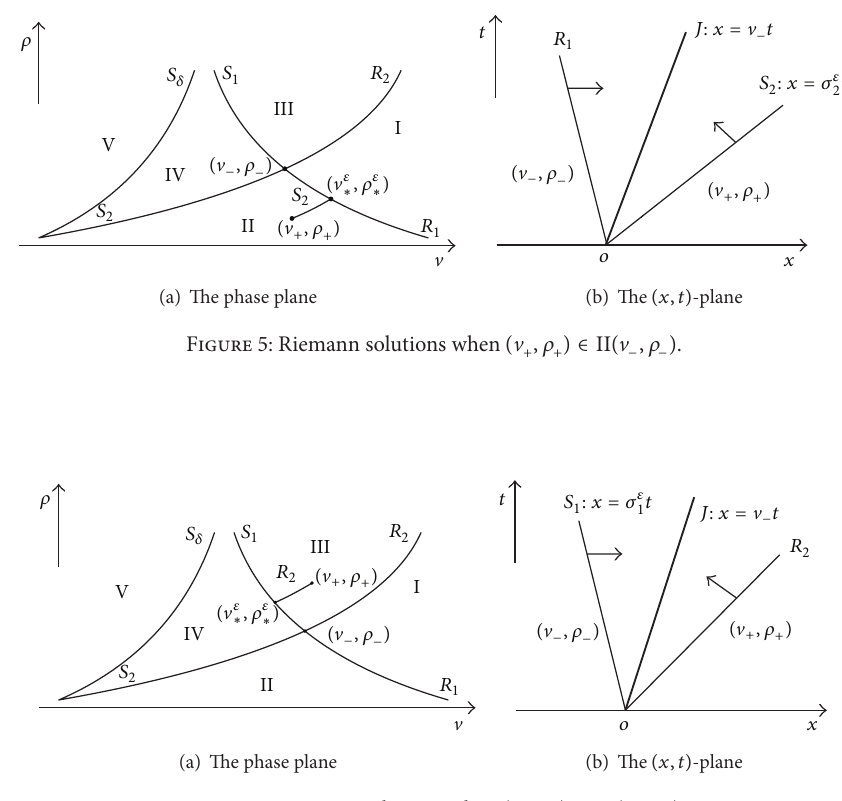
Figure 6: Riemann solutions when ( V + ,𝜌 + ) ∈ III ( V − , 𝜌 − )